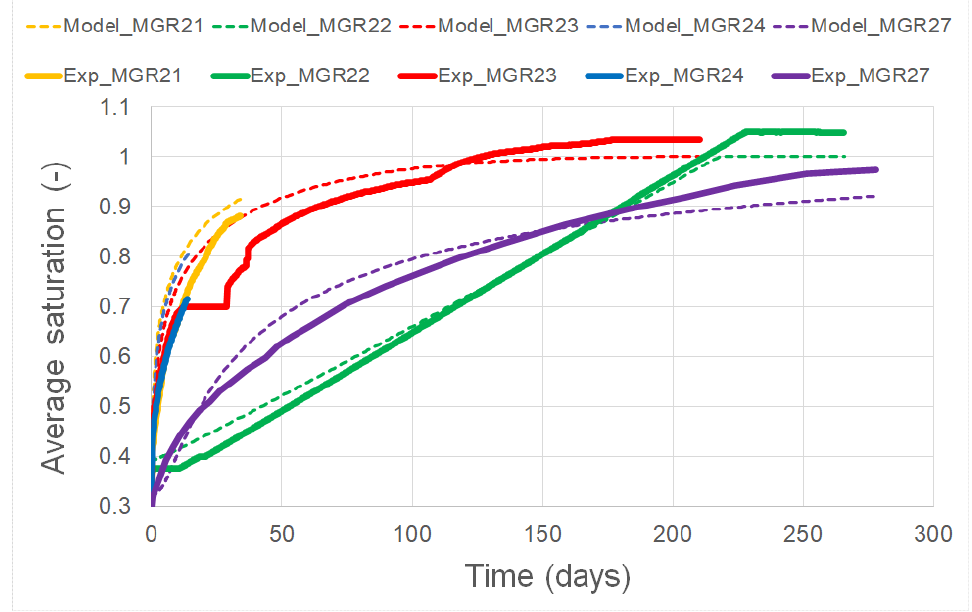
Figure 4. Comparison of modeling results (dashed line) and the measurements (solid line) of average saturation in the whole sample.